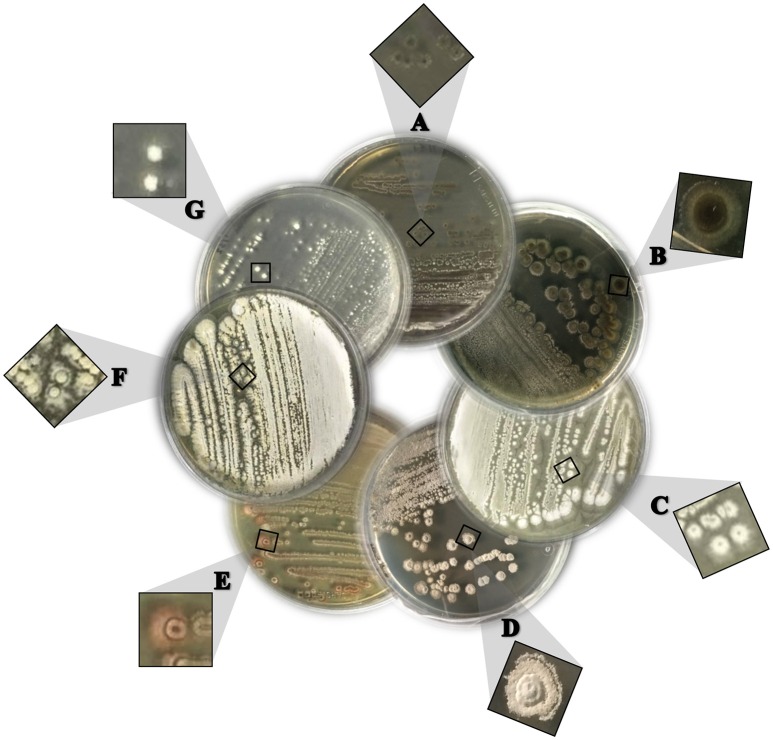
Seven different phenotypes (A–G) based on the colony morphology of the representative Streptomyces spp. strains grown on starch casein agar medium.